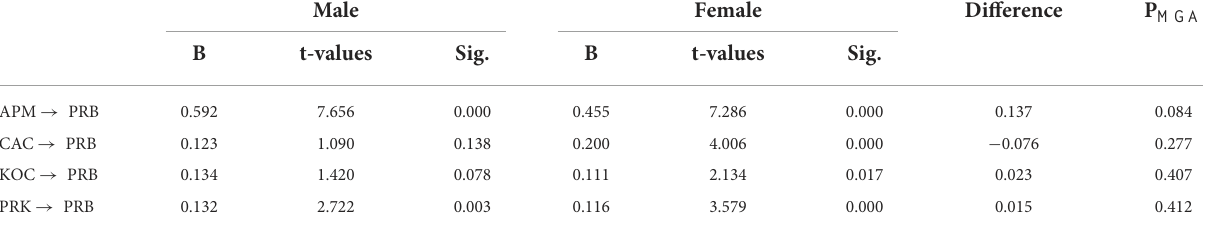
TABLE 14 Multiple group comparison based on